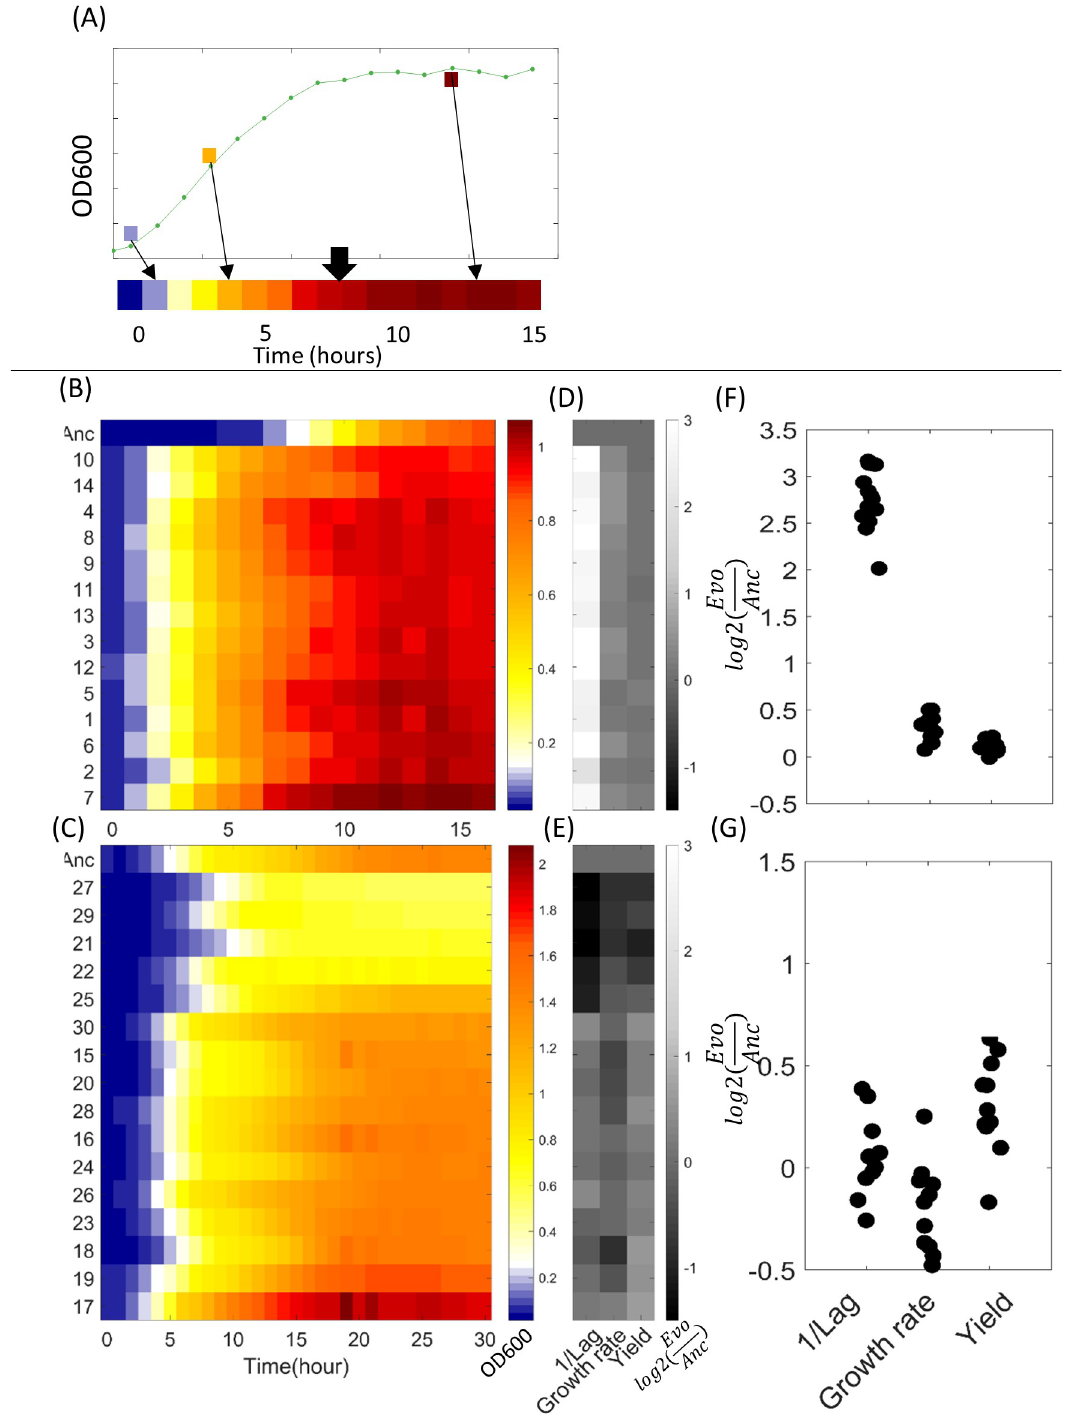
Fig 3. Growth experiments of individual strains. All strains were grown for approximatley 30 hours in 15˚C and 20˚C ( E . coli and S . cerevisiae , respectively), while measuring OD600 every approximately 1.5 hours. (A) Schematic representation of transforming growth curves into heat map figure. Each point in the growth curve is colored based on its OD600 value to obtain the heat map figure. (B-C) Growth in heat map format. Each row corresponds to a strain. Color bar represents OD600 values. Growth experiments were done in 11 replicates per strain. (B) E . coli (SD doesn’t exceed 0.02). (C) S . cerevisiae (SD doesn’t exceed 0.17). Strains in each species are sorted in ascending order according to final OD. (D-G) Growth parameters (lag, growth rate, and yield) were